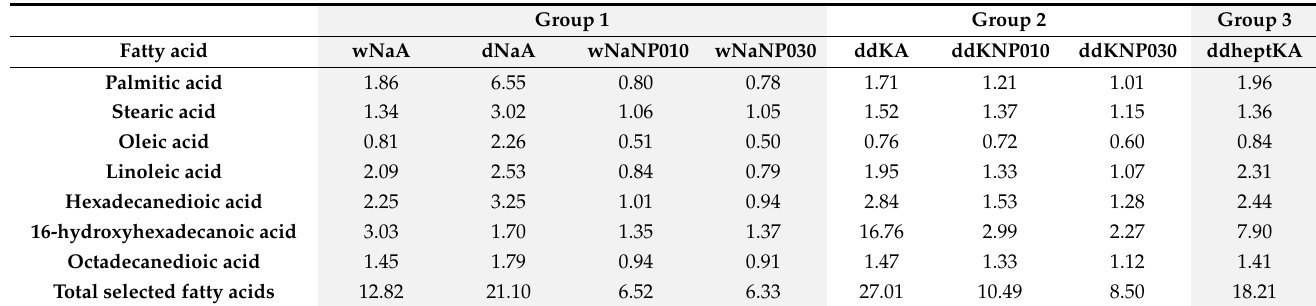
Table 6. GC-FID analysis of the constituents identified in cutin samples. Results are given as % (w fatty acid /w freeze-dried extract